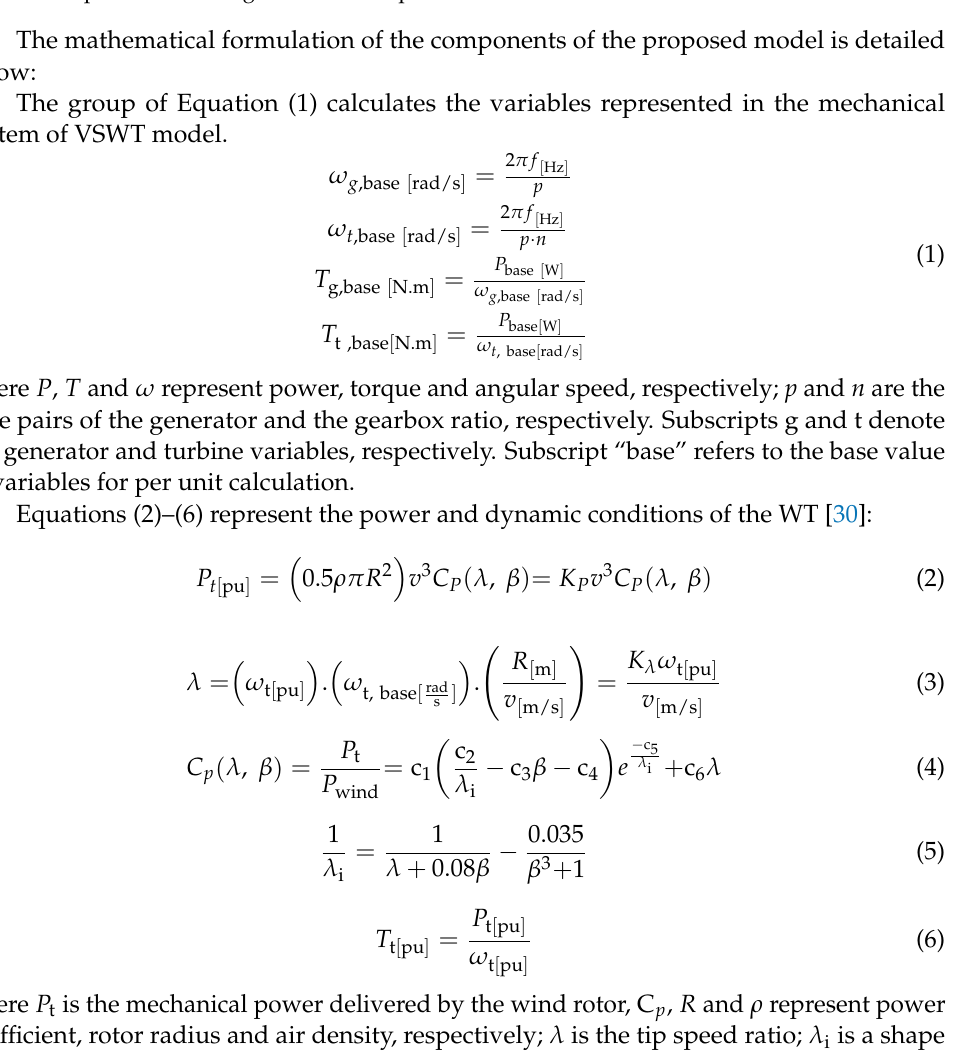
Figure 1. Representative diagram of the simplified model VSWT.